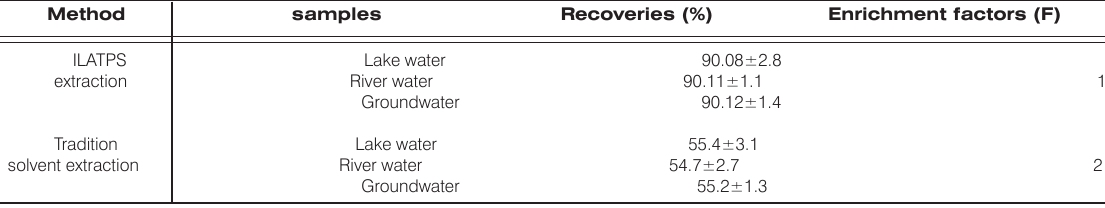
Table 4. The comparison results between ILATPS extraction and tradition solvent extraction.